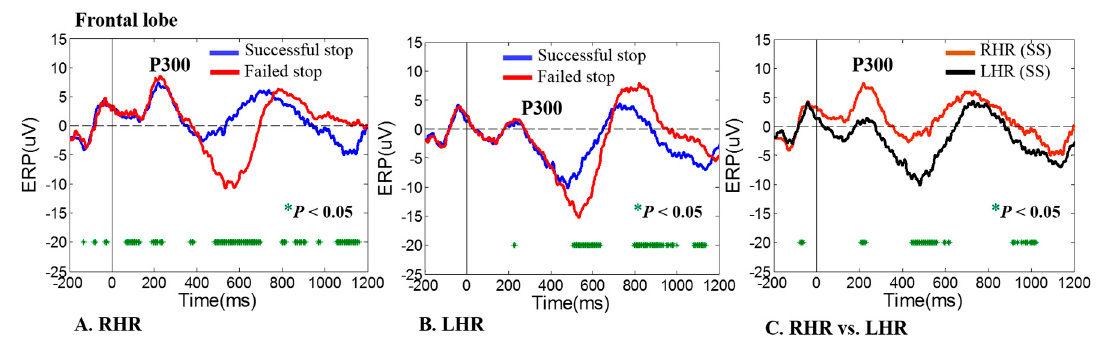
Figure 4. An event-related potential (ERP) of P300 wave was obtained in frontal lobe (FZ) during right-hand response (RHR) and left-hand response (LHR) inhibitions in successful stop (SS) and failed stop (FS) trials. Asterisk display significant difference between SS vs. FS trials by Wilcoxon signed rank test ( P < 0.05). ( A ) An ERP-P300 wave was investigated in frontal lobe (FZ) during RHR inhibition in SS and FS trials. ( B ) An ERP-P300 wave was observed in frontal lobe (FZ) during LHR inhibition in SS and FS trials. ( C ) An ERP-P300 wave was found during RHR (SS) and LHR (SS). The X-axis displays time in millisecond and Y-axis shows ERP.